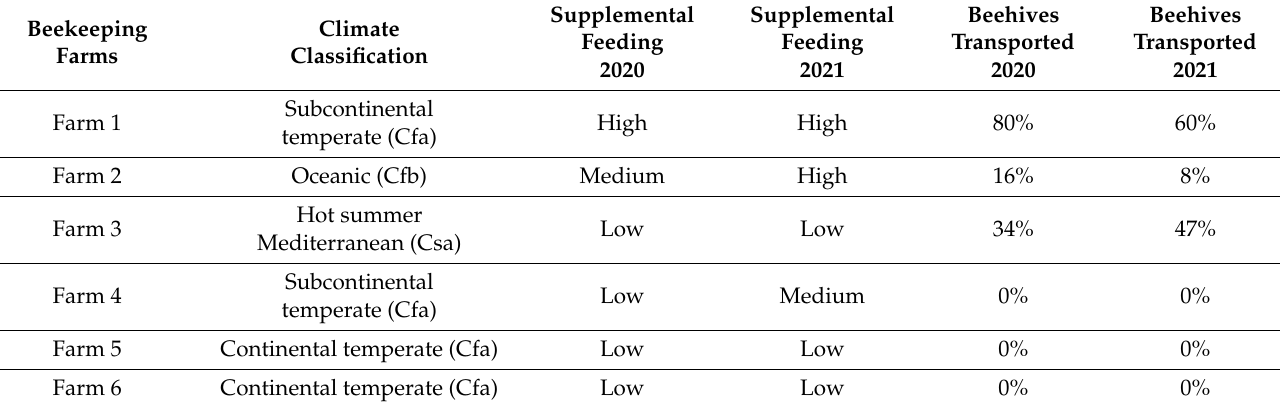
Table 1. Beekeeping farms analyzed in the study